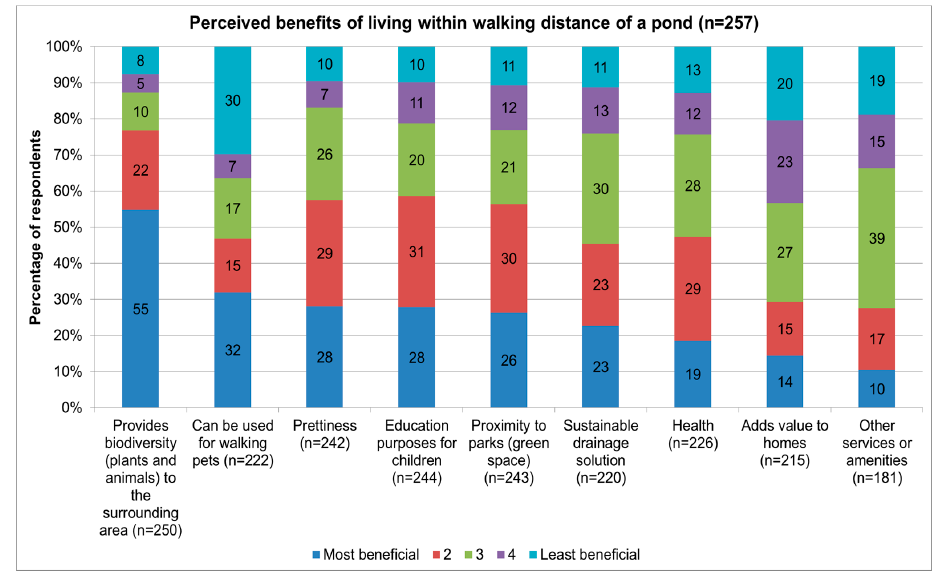
Figure 3. Perceived benefits of living next to a pond (within walking distance), rated 1: Greatest benefit to 5: Least benefit.